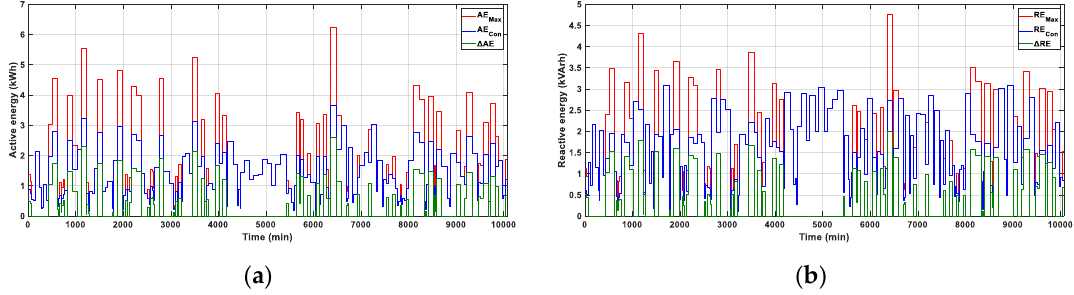
Figure 15. Weekly energy of IM 3.0 kW (IMEMSL #4): ( a ) Active energy; ( b ) Reactive energy.